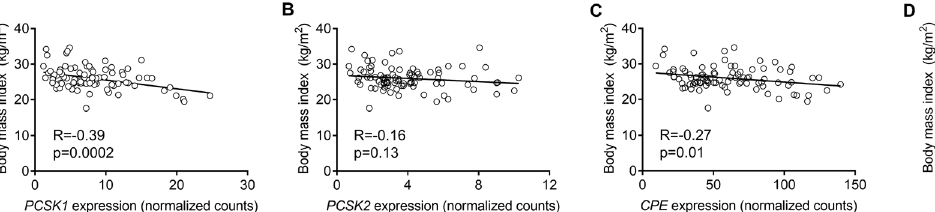
Fig. 6 | Islet PCSK1 expression negatively correlates with body mass index in humans.A – D Correlation of body mass index of donors and whole islet mRNA expressionof A PCSK1 , B PCSK2 , C CPE ,and D SCG5 .Thedatasetdidnotcontain